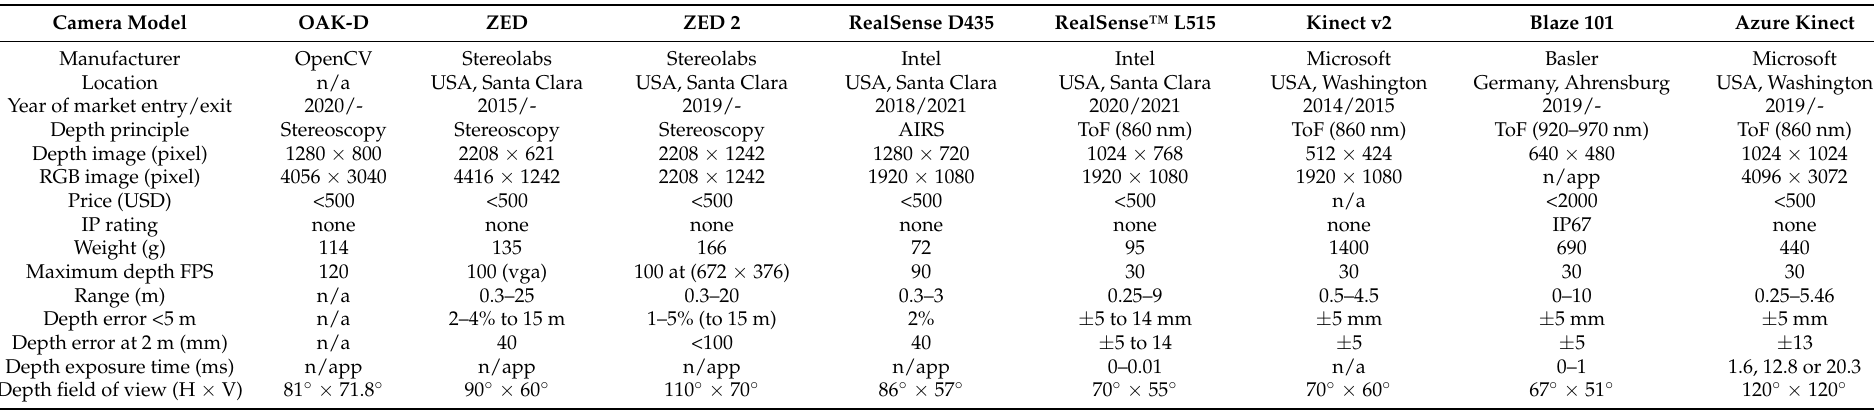
Table 1. Comparison of technical specifications of depth sensors used in this study. Information is from manufacturer specifications, except ToF wavelength data for Kinect v2, which is from [28]. Depth error is generally reported as standard deviation of repeated measurements at a set distance. n/a—not available; n/app—not